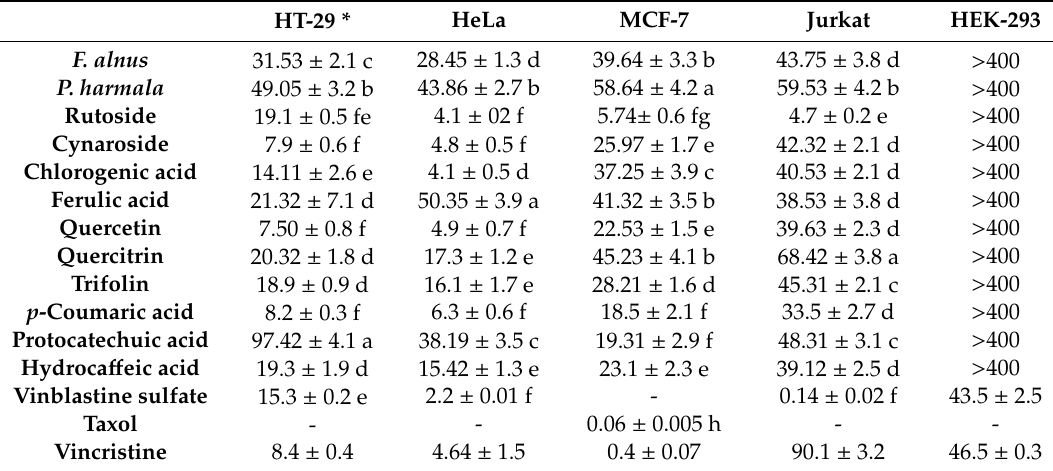
Table 3. Antiproliferative activity of F. alnus and P. harmala methanolic extracts, quercitrin, cynaroside, trifolin, p -coumaric acid, rutoside, quercetin, chlorogenic acid, ferulic acid, hydroca ff eic acid, and protocatechuic acid [IC 50 ( µ g mL -1 )] against di ff erent cancer cells. HT-29 * HeLa MCF-7